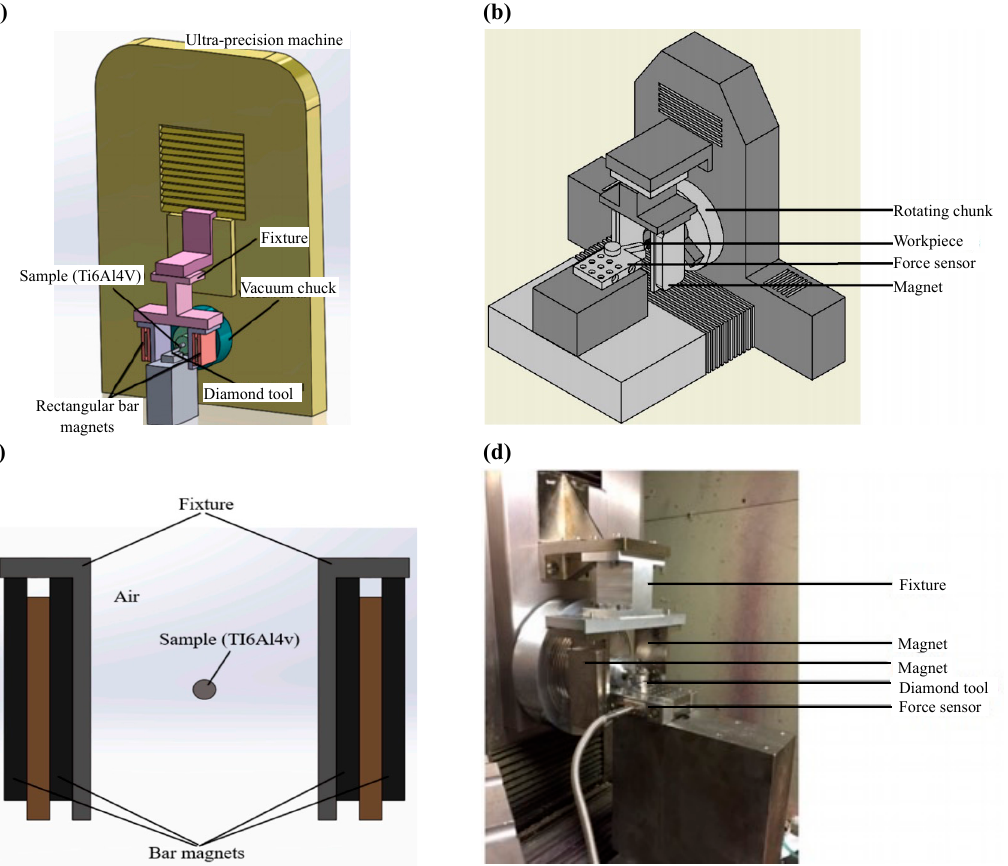
Figure 27. ( a ) Modeling of the machine layout when Khalil et al. [190] use magnetic field assist. ( b ) Modeling of the machine layout when Yip and To use magnetic field assistance. ( c ) Schematic of the distribution of permanent magnet and workpiece positions when using magnetic field assist, adapted with permission from Ref. [190] 2022, Elsevier. ( d ) Actual machine layout when Yip and To use magnetic field assist, adapted with permission from Ref. [186] 2017, Elsevier.